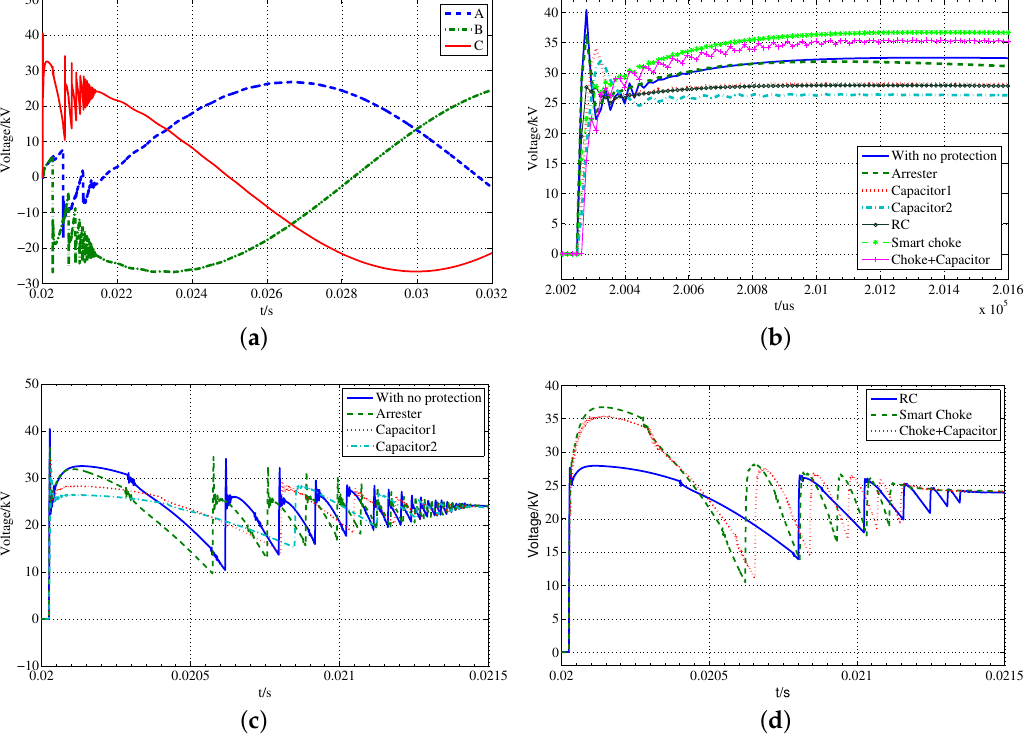
Figure 11. The effectiveness comparison of different mitigation methods: ( a ) the trasient overvoltages (TOVs) at the HV side of WTT1 without any mitigation methods; ( b ) the front of TOVs at the HV side of WTT1 without any mitigation methods; ( c ) WTT1 voltage comparison with former four mitigation methods; and ( d ) WTT1 voltage comparison with latter three mitigation